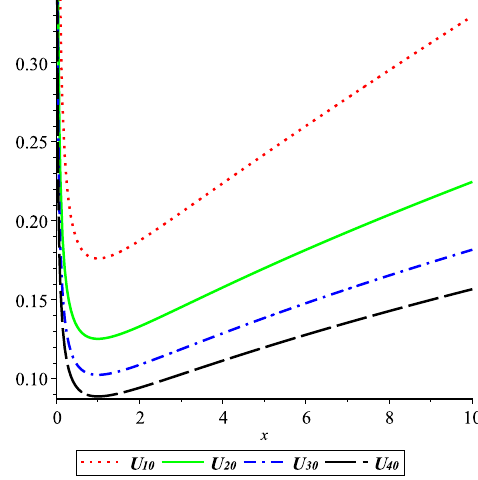
Figure 1. Graphics of U n for n =